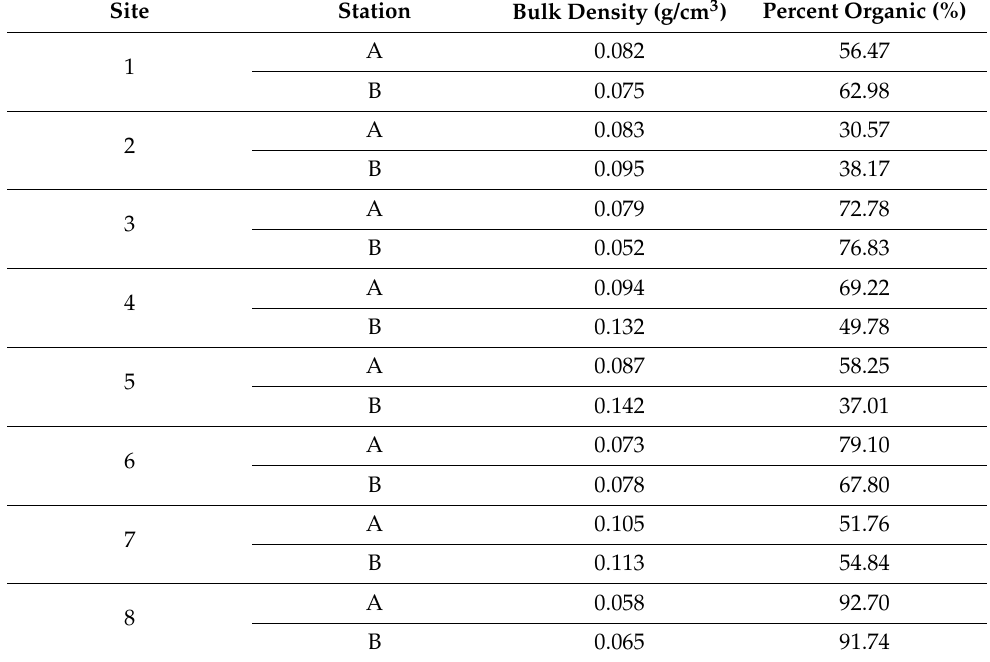
Table 1. Soil bulk density and percent organic matter at the reference site (1) and seven sites located in the Lac des Allemands